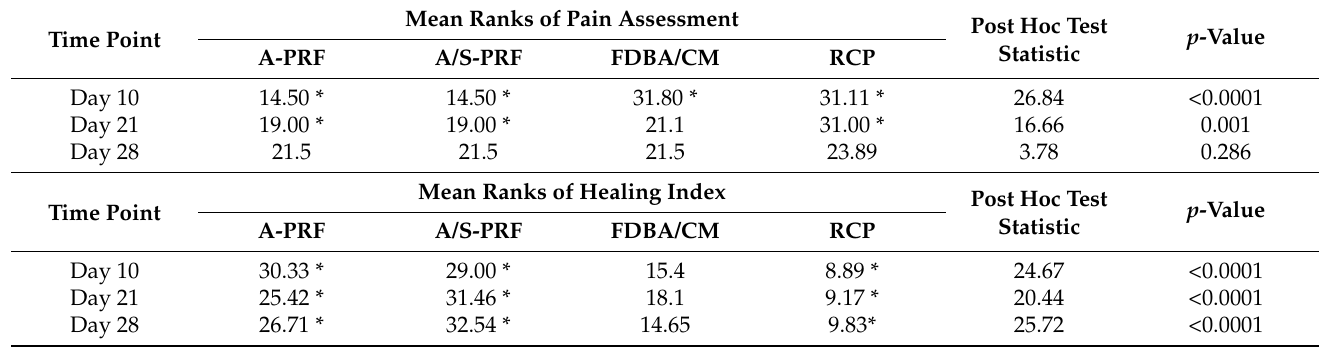
Table 3. Comparison of mean ranks of pain assessment and healing index on day 10, day 21, and day 28 among the 4 study